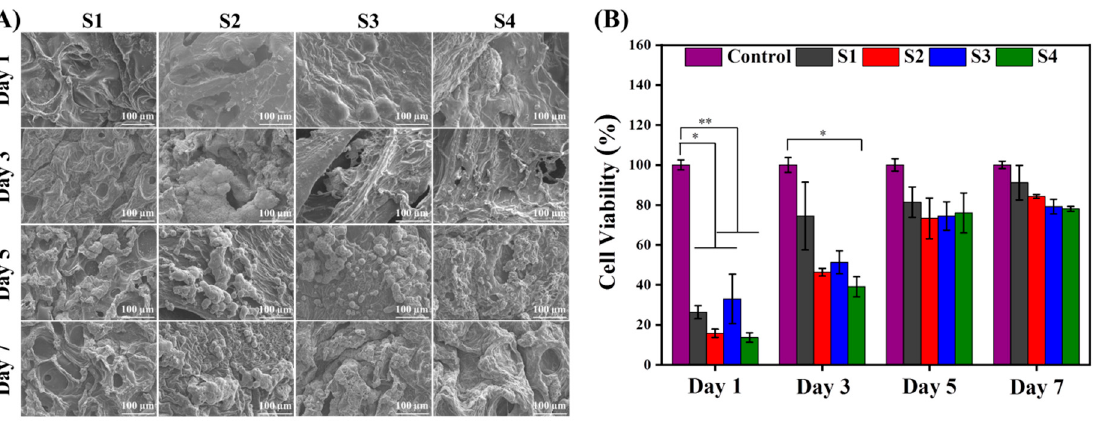
Figure 8. ( A ) SEM images and ( B ) MTT assay of S1, S2, S3, and S4 hydrogels after 1, 3, 5, and 7 days of cell culture (pre-osteoblast cells). ** p ≤ 0.01, * p ≤